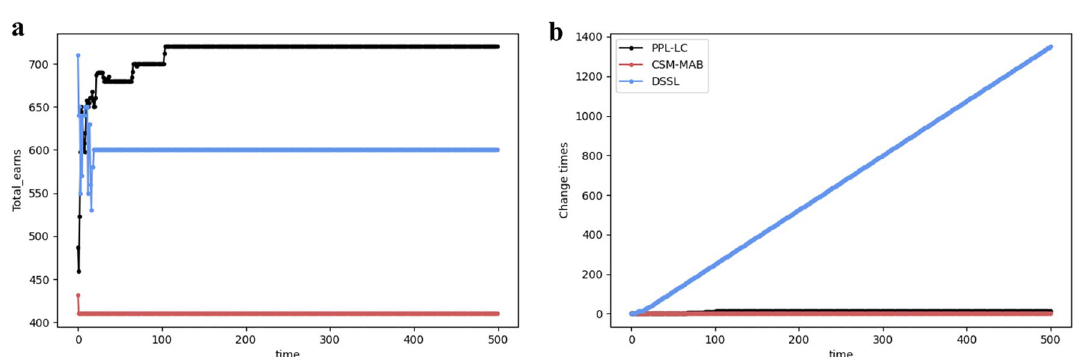
Figure 9. The performance comparison of the PPL-LC, DSSL, and CSM algorithms. ( a ) The trend of transmitted information bits over time. ( b ) The performance exchange times over